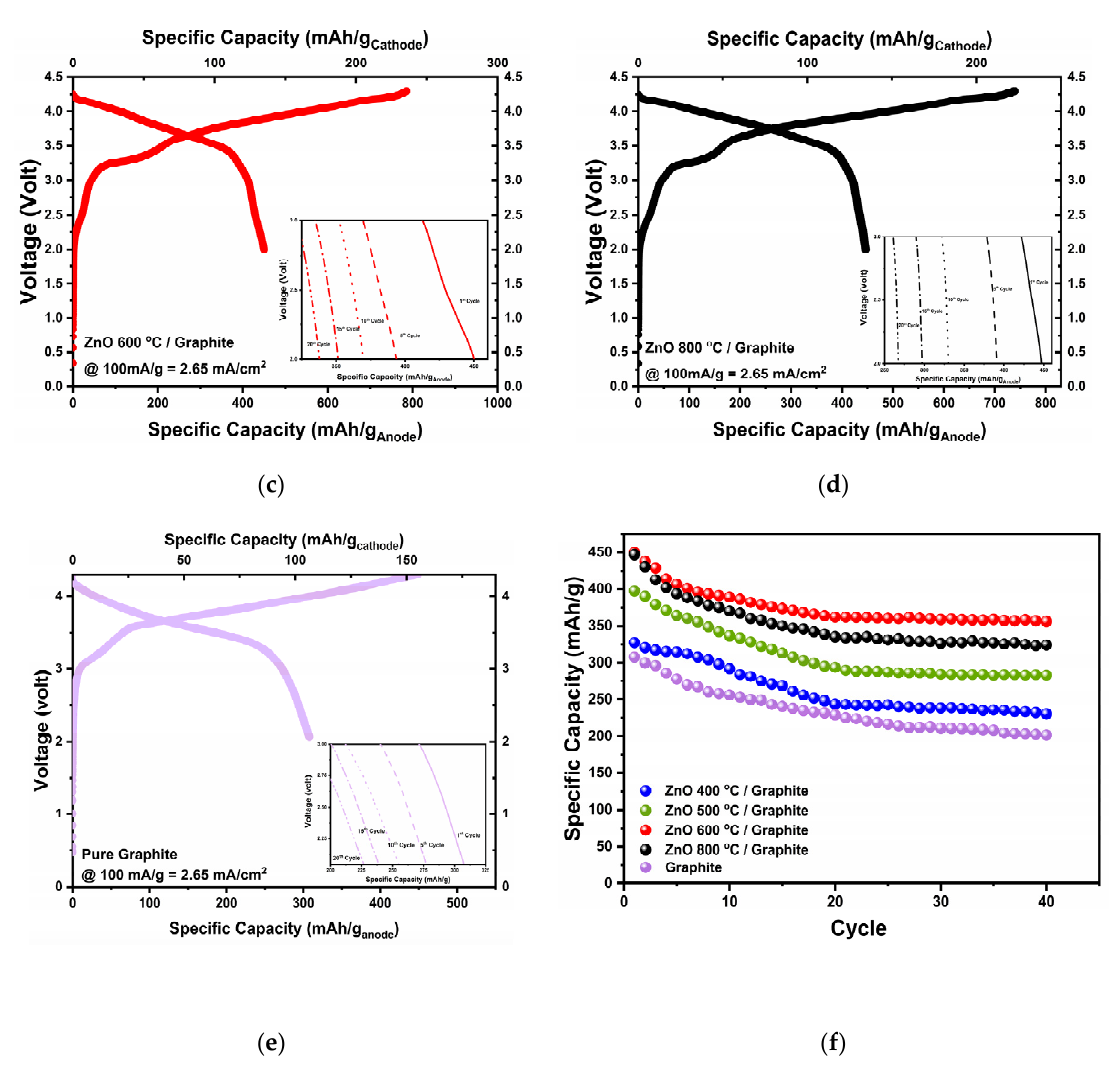
Figure 7. ( a – e ) Charge–discharge curve of NMC622|ZnO/Graphite and NMC622|graphite cells with various ZnO samples and ( f ) the cycle performance of all samples. Table 6. The charge–discharge capacity and energy density of NMC/ZnO/graphite cells.